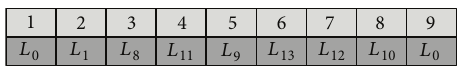
Figure 2: A feasible chromosome encoding in GA